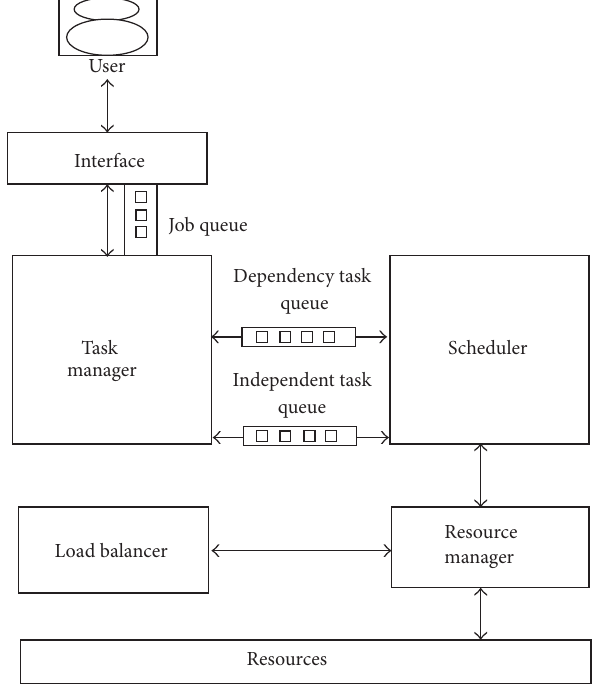
Figure 1: Scheduling and load balancing